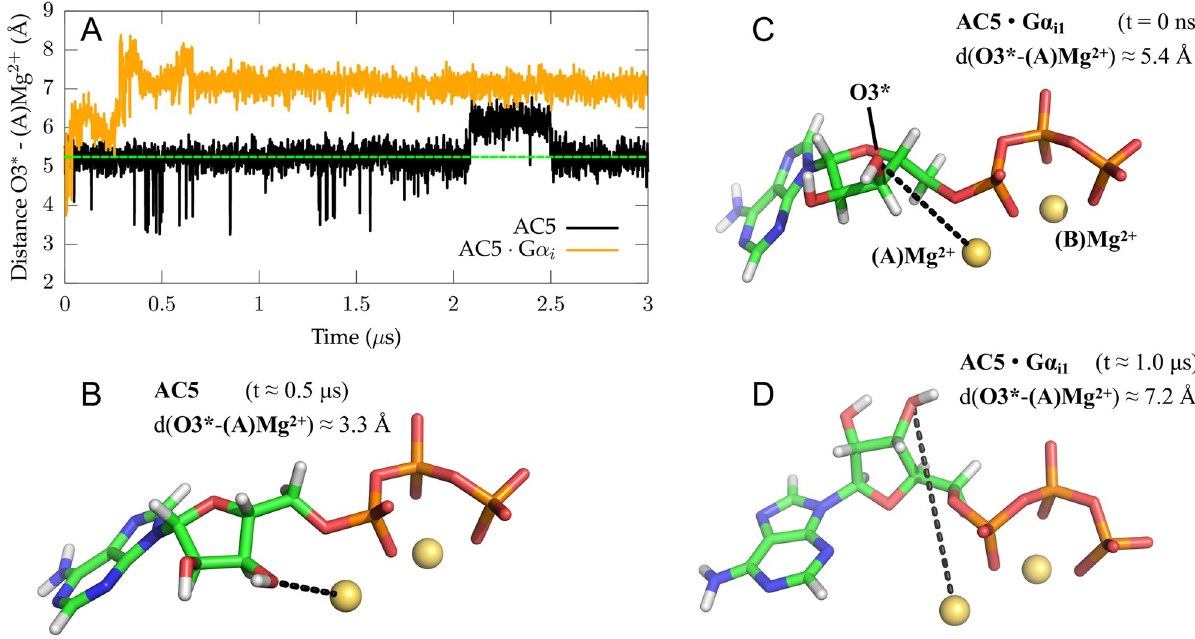
Fig 5. ATP sampled conformations. The distance between ATP’s ribosyl oxygen O3 � and the neighbouring Mg 2 þ both holo free AC5 and the AC5:G α i 1 complex in image (A). The starting distance corresponding to the value found in the X-ray structure (PDB ID: 1CJK) is shown by a green dashed line. Snapshots of three representative conformations sampled by ATP and its neighbouring Mg 2+ ions are shown in stick (for ATP) and ball (for Mg 2+ ) representation and were extracted from the simulated trajectories of holo G α -free AC5 at 500 ns (B) and the holo AC5:G α binary complex at 0 ns (C) and at 1 μ s i 1